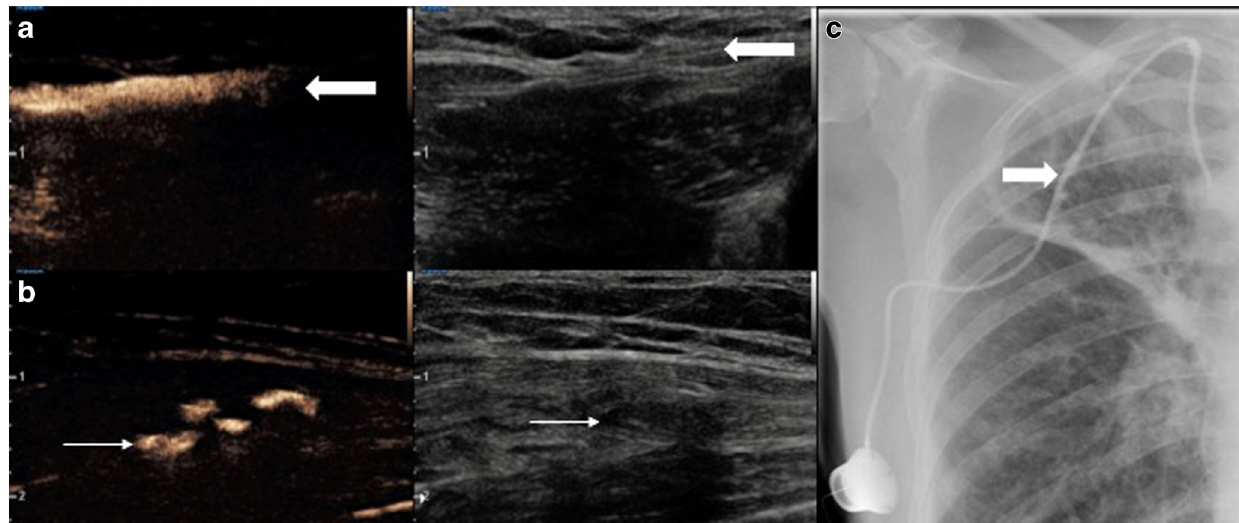
Fig. 11 Contrast ultrasound agent administered through a B port-a-cath ^ for a malfunctioning line causing point tenderness. (A) CEUS and corresponding greyscale image. The subcutaneous course of the line is seen (thick arrow) and luminal patency is confirmed on the contrast image. (B) At the point of tenderness there is contrast extravasation